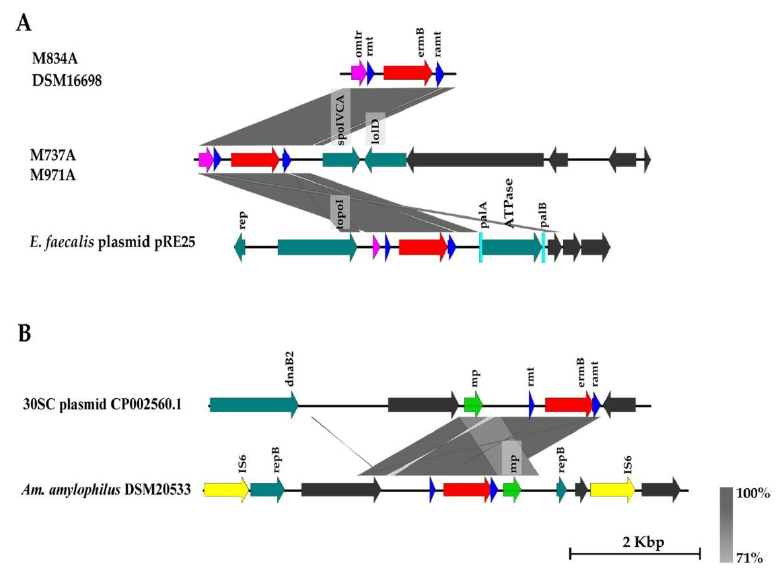
Figure 4. Organization of CDS in the contigs harboring ermB gene. ( A ) contigs bearing omega transcriptional repressor ( omtr ) near ermB . ( B ) CDS pattern with mobilization protein ( mp ) near the ermB gene. A and B: dark blue arrow — 23S rRNA methyl transferase ( rmt ) and rRNA adenine methyl- transferase gene ( ramt ), red arrow — ermB gene, teal arrow — CDS with functional annotation, gray